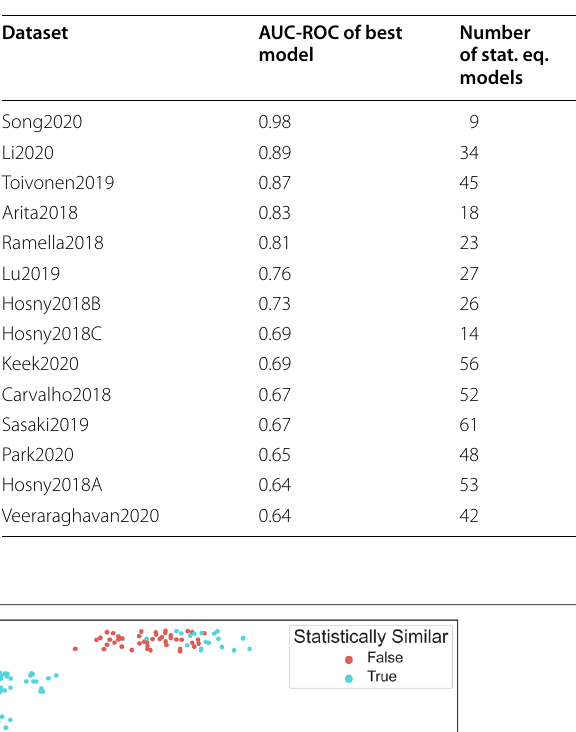
Table 4 Counts of how many models were statistically not different to the best model for each dataset, sorted by